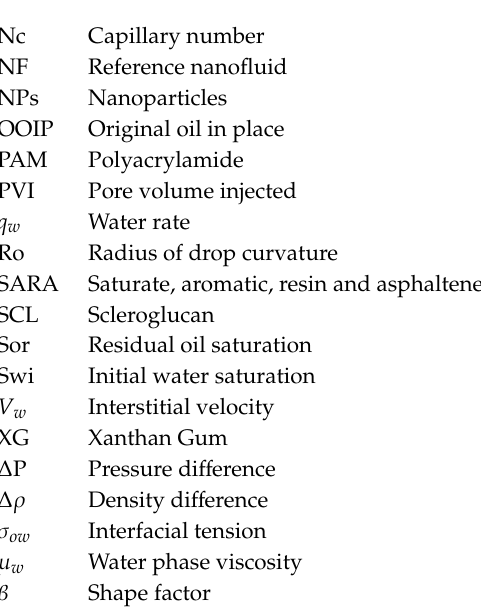
Binary images after the segmentation process from the images of the microfluidic tests. The images were used the calculate the behavior of the oleic phase (white) during the time for each recovery agent in the three different scenarios of the study. Table A1. Images segmented using the Matlab code in the function of the porous volume injected (PVI) during the recovery agent injection. The fluids are the brine, xanthan gum, and Scleroglucan for the microfluidic screening of biopolymer solutions. V I Brine XG SCL P P PVI Brine